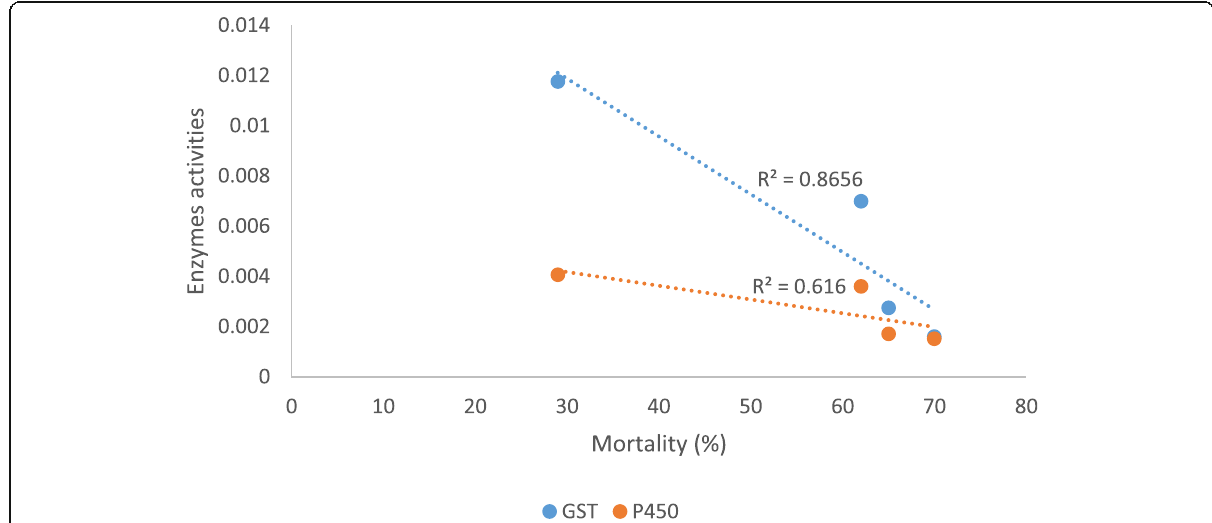
Fig. 3 Regression of mortality rate of Aedes aegypti exposed to permethrin and mean level enzymes activity in four LGAs from Lagos state,